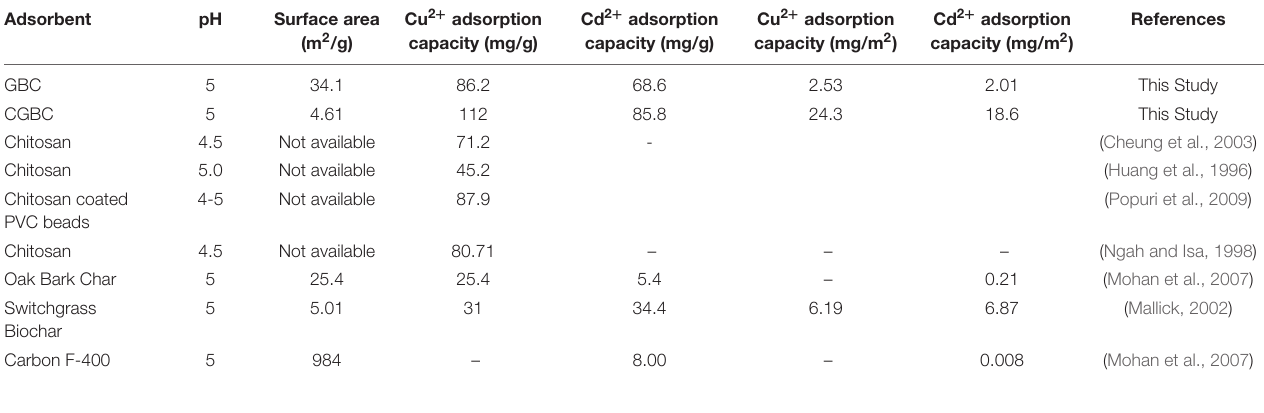
TABLE 5 | Comparison of GBCs’ and CGBCs’ metal adsorption capacity with other biochars, chitosan, and activated carbon.